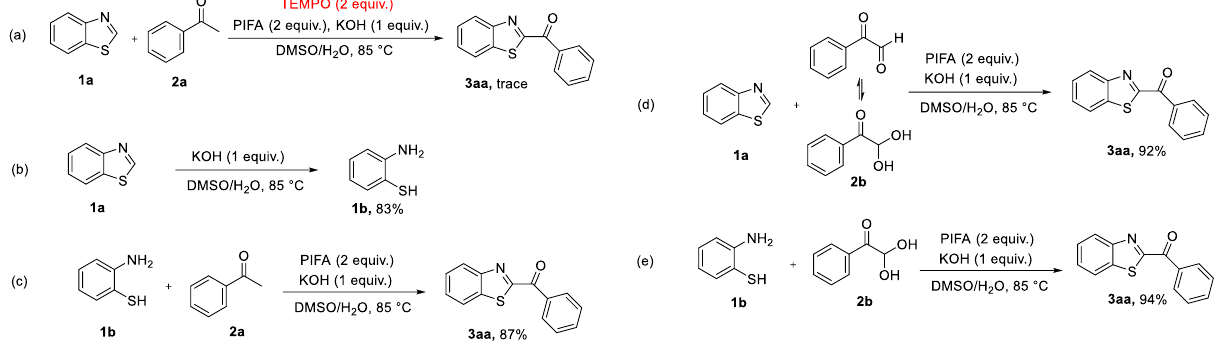
Figure 5. Mechanistic experiments.